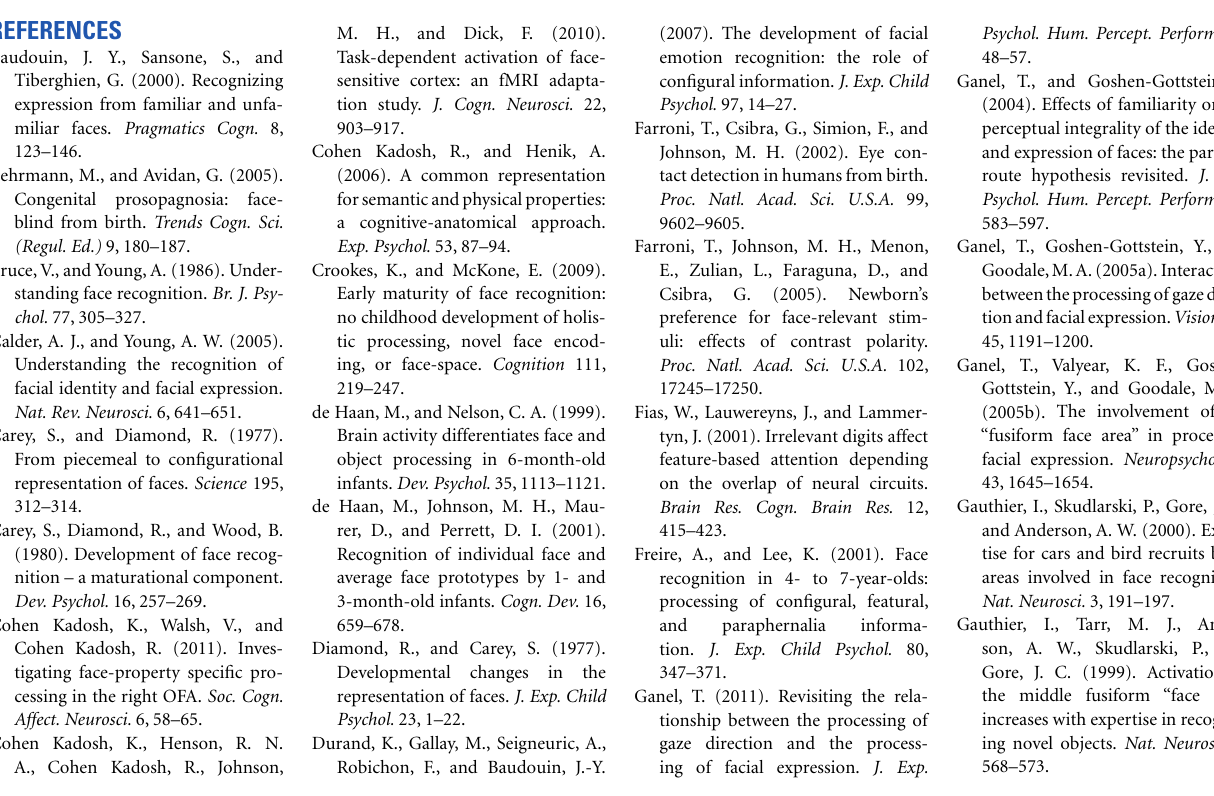
overall face processing is adult-like in 7-year-old children, spe- cific properties that depend on configural information processing continue to lag behind until 11 years-of-age, thus stressing the dependence of factors such as exposure and training for this stimulus